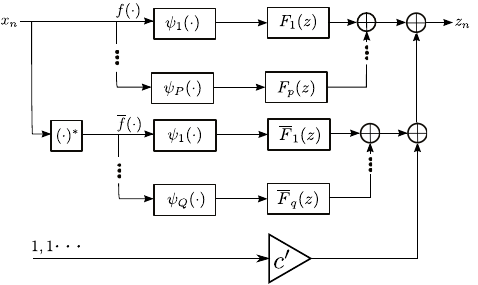
Figure 1. Predistorter structure for the joint predistor- tion of PA and I/Q modulator impairments.